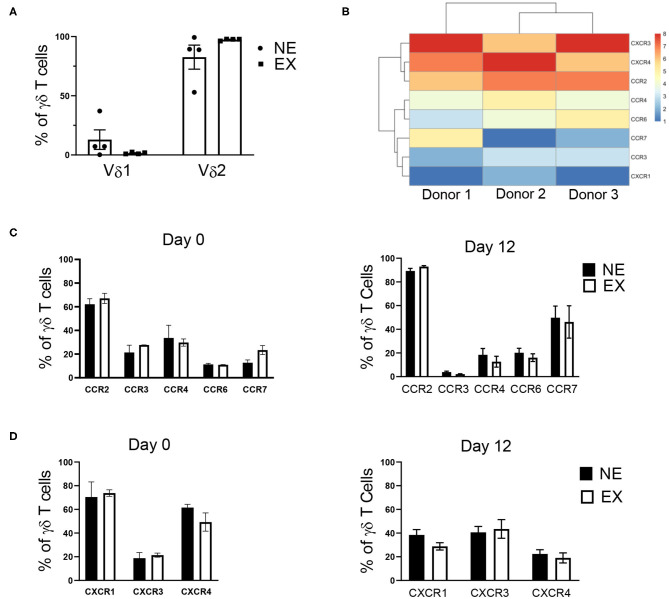
γδ T cell receptor subtype and chemokine receptor expression analyzed via flow cytometry and RNA-sequencing. (A) The majority of γδ T cells expanded from both NE (n = 4) and EX (n = 4) were of the Vδ2 subset. (B) RNA-sequencing revealed that CCR2, CXCR3, and CXCR4 had the highest expression of the chemokine receptors expressed on γδ T cells at the end of expansion. (C) There was no difference in CC receptor expression on γδ T cells from NE or EX on day 0 or day 12 of expansion. Of the CC chemokine receptors, CCR2 was highly expressed, while CCR4, CCR6, and CCR7 were only moderately expressed. CCR3 had the lowest expression of any chemokine receptors evaluated. (D) CXCR1, CXCR2, and CXCR4 were expressed at moderate levels on γδ T cells from both NE and EX on both day 0 and day 12 of expansion.